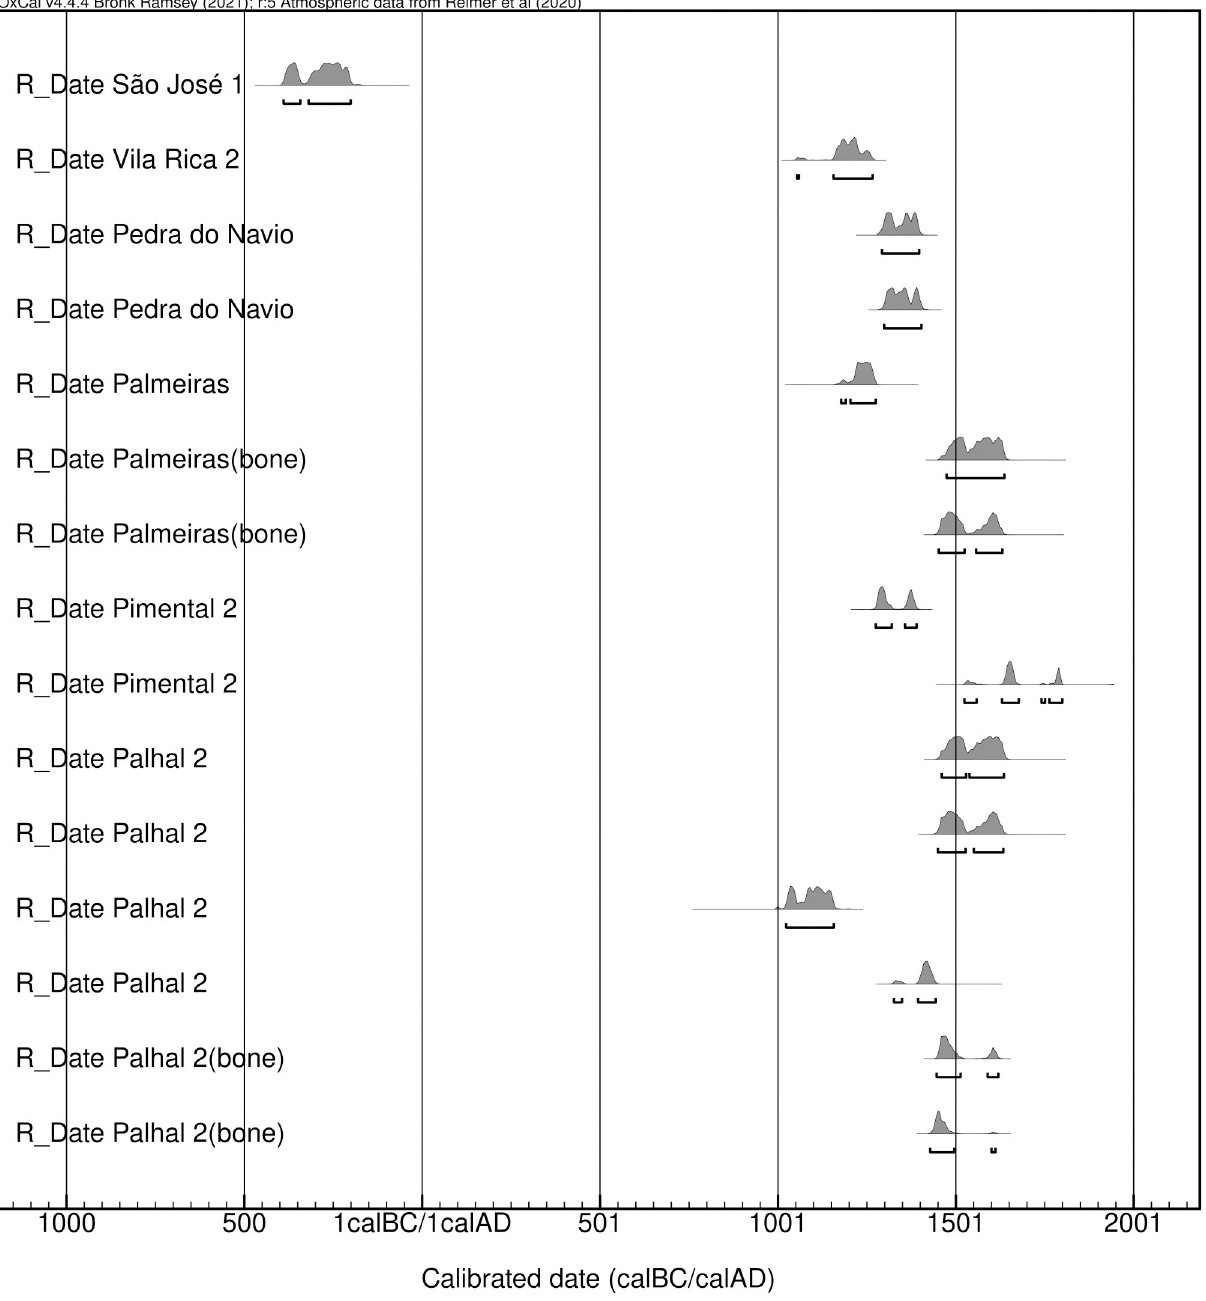
Fig 2. Dates from archaeological sites from VGRX. Most were occupied in the last millennium. Calibrations performed online using OxCal 4.4.4.